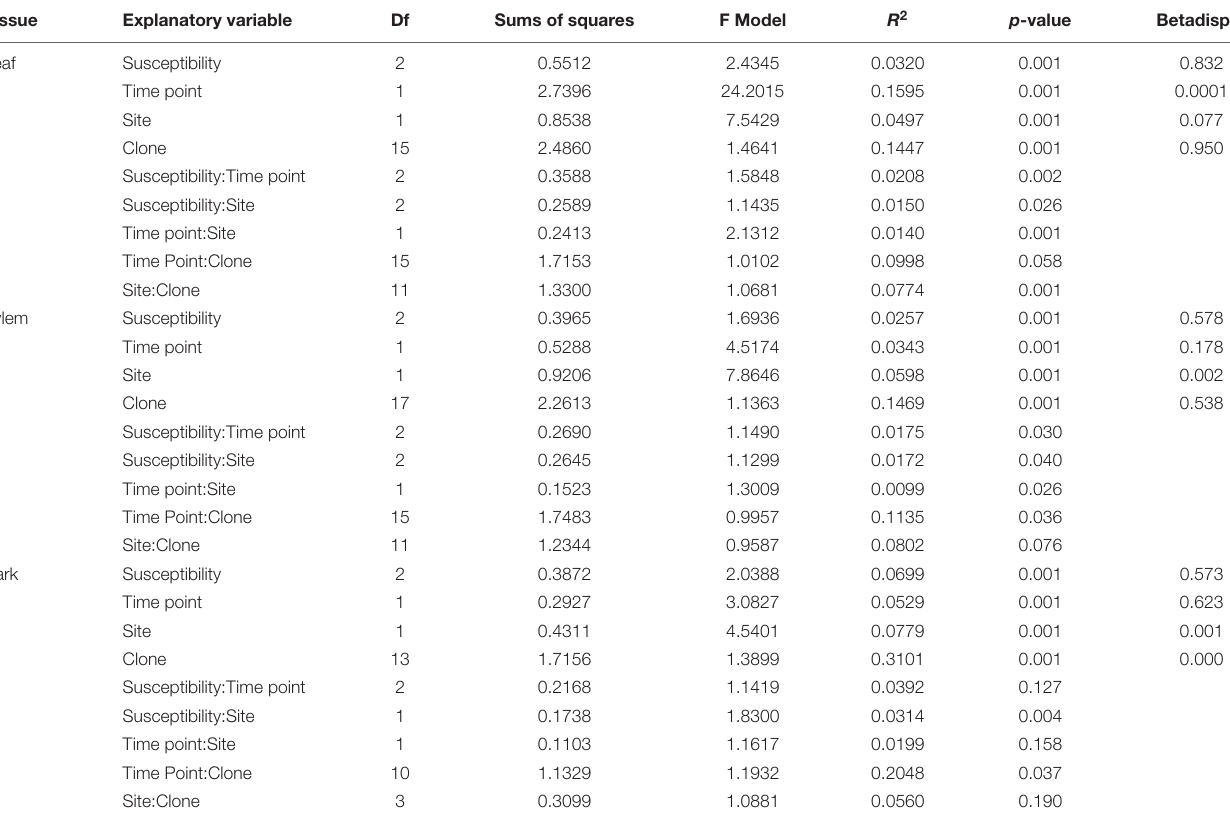
TABLE 5 | Factors explaining fungal community composition in different tissue.